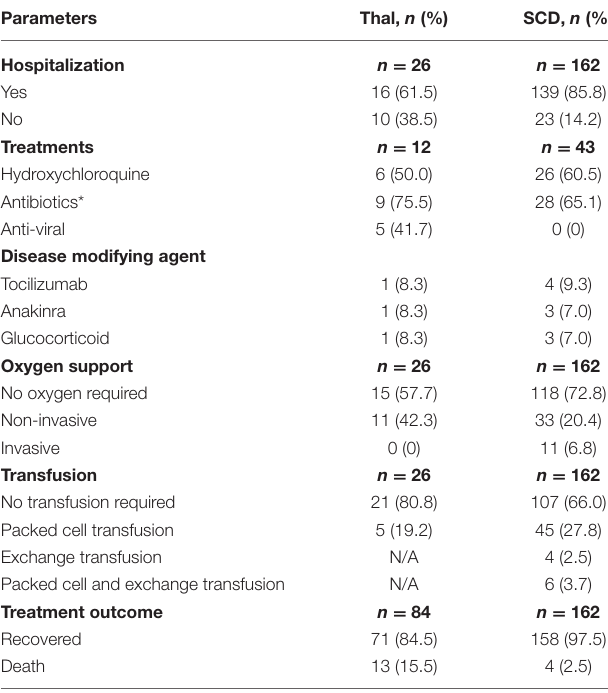
TABLE 4 | Summary of treatments received and outcome of study